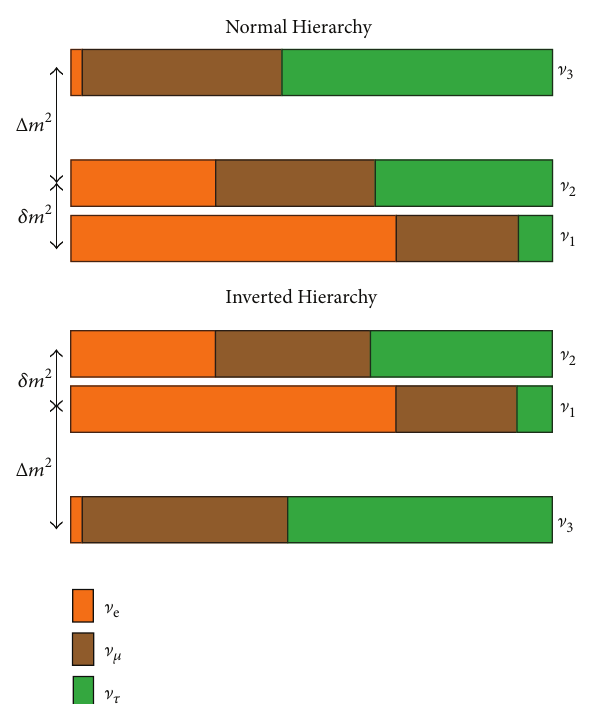
Figure 7: Graphic view of the probability of finding one of the flavor eigenstates if the neutrino is in a certain mass eigenstate. The value 𝜙 = 0 for the CP-violating phase is